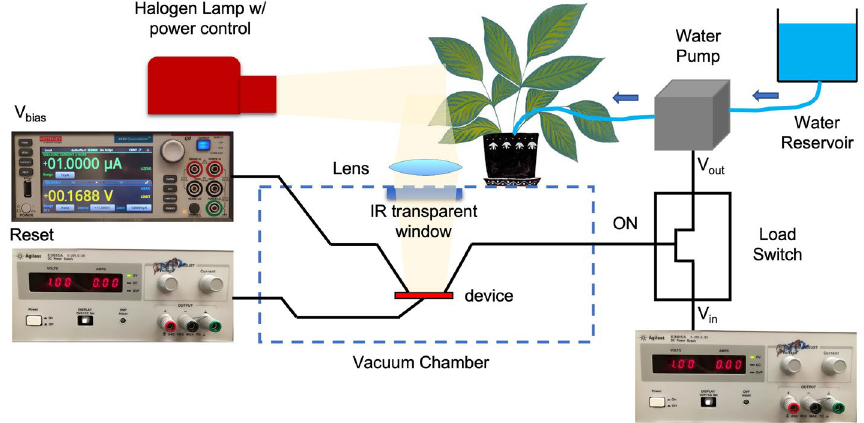
Figure 3. Schematic of the experimental setup used to demonstrate the zero standby power SWIR soybean plant water stress detection. It includes a Quartz tungsten halogen lamp (sunlight simulator), a soybean alive plant, a lens, a vacuum chamber where the PMP was placed, a load switch, a water reservoir and a water pump. The PMP was connected to a source-meter to apply the V bias and to monitor the switch current. It was also connected to a separate DC supply to apply the reset pulse. Another DC supply was used as V in of the load switch. A moderate water-stress condition of the plant (RWC = 68%) resulted in the PMP closing and, as a consequence, triggering the ON port of the load switch. At that point V out = V in resulting in the activation of the water pump which was programmed to pump 20 ml of water over 20